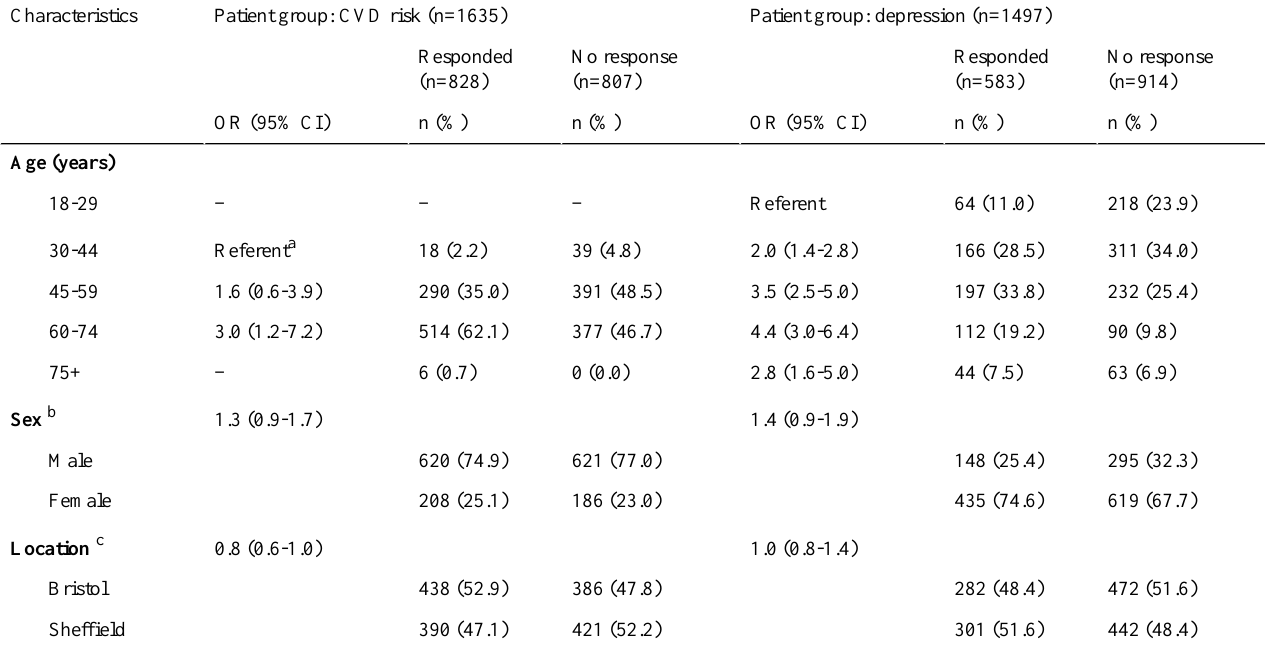
Table 1. Demographic differences between responders and non-responders by patient group.